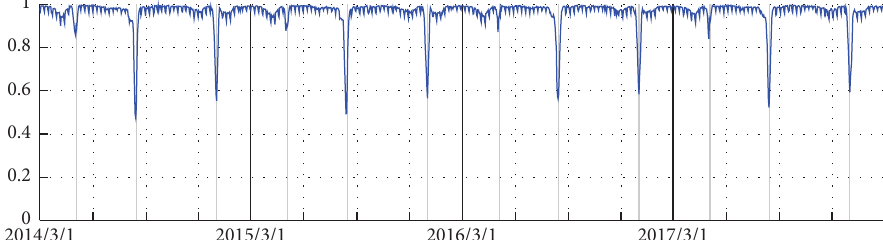
Figure 11: Time-series changes in correlation coefcients between the destination amenity at one day and one of the all-time points